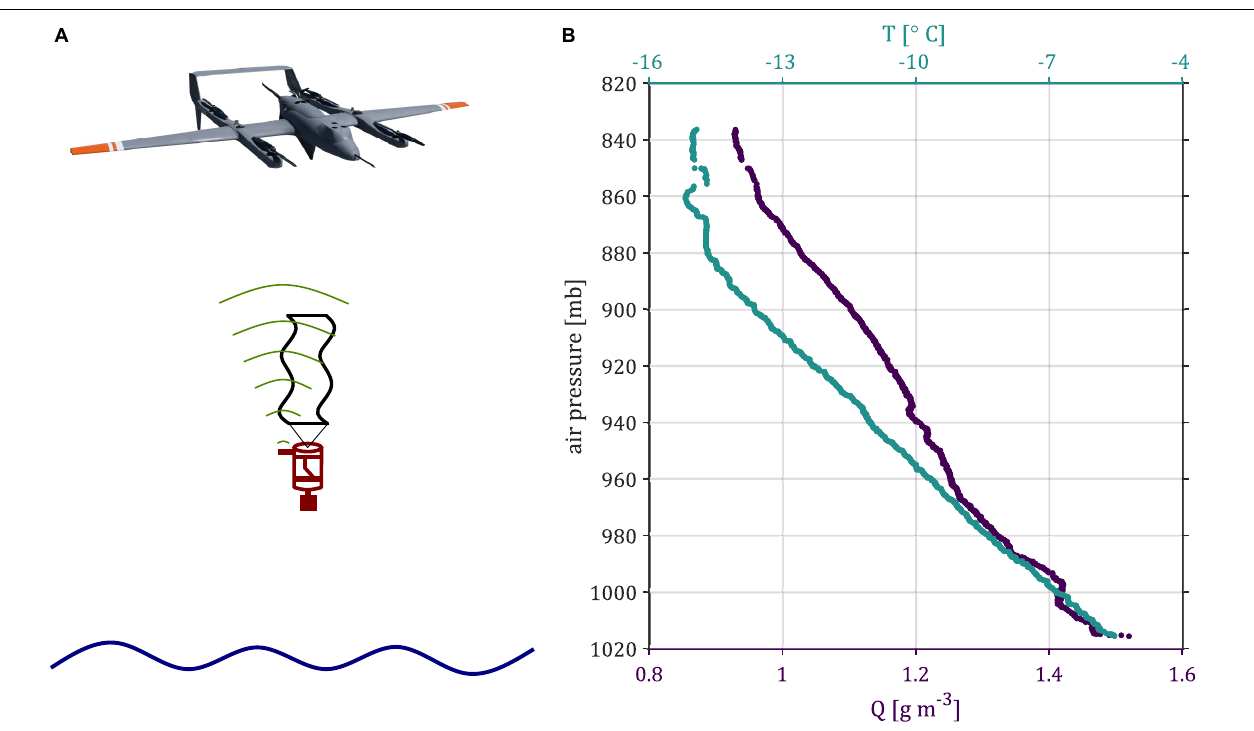
FIGURE 11 | (A) Representation of the DD µ D being ejected from the UAV and collecting data while falling through the atmosphere. (B) Air temperature (teal) and absolute humidity (violet).